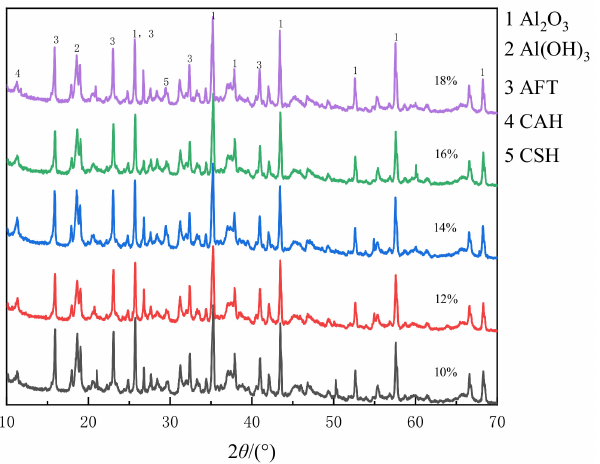
Figure 9. XRD analysis results of aluminum dross non-fired bricks under different mixing-water amounts.